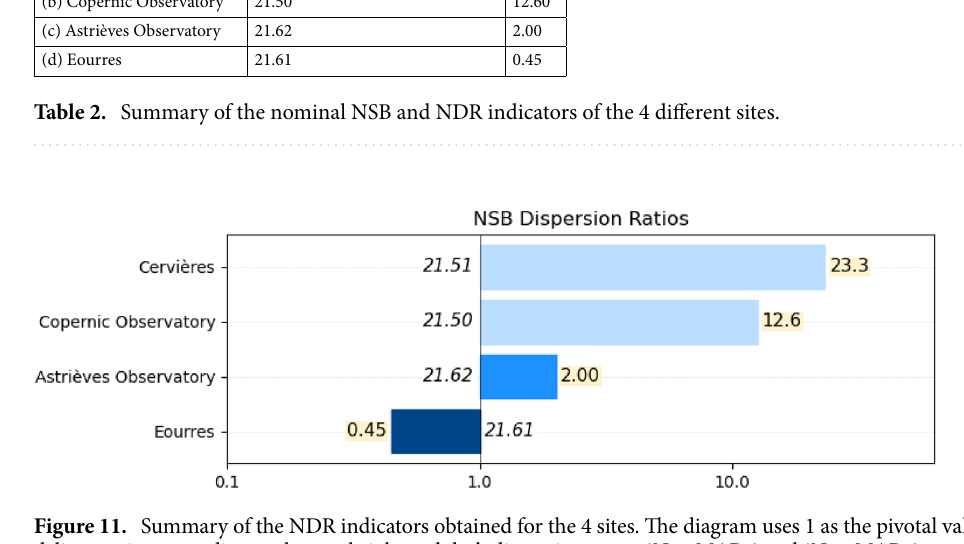
Figure 11. Summary of the NDR indicators obtained for the 4 sites. The diagram uses 1 as the pivotal value to delineate sites according to the two bright and dark dispersion terms ( N b · MAD b ) and ( N d · MAD d )